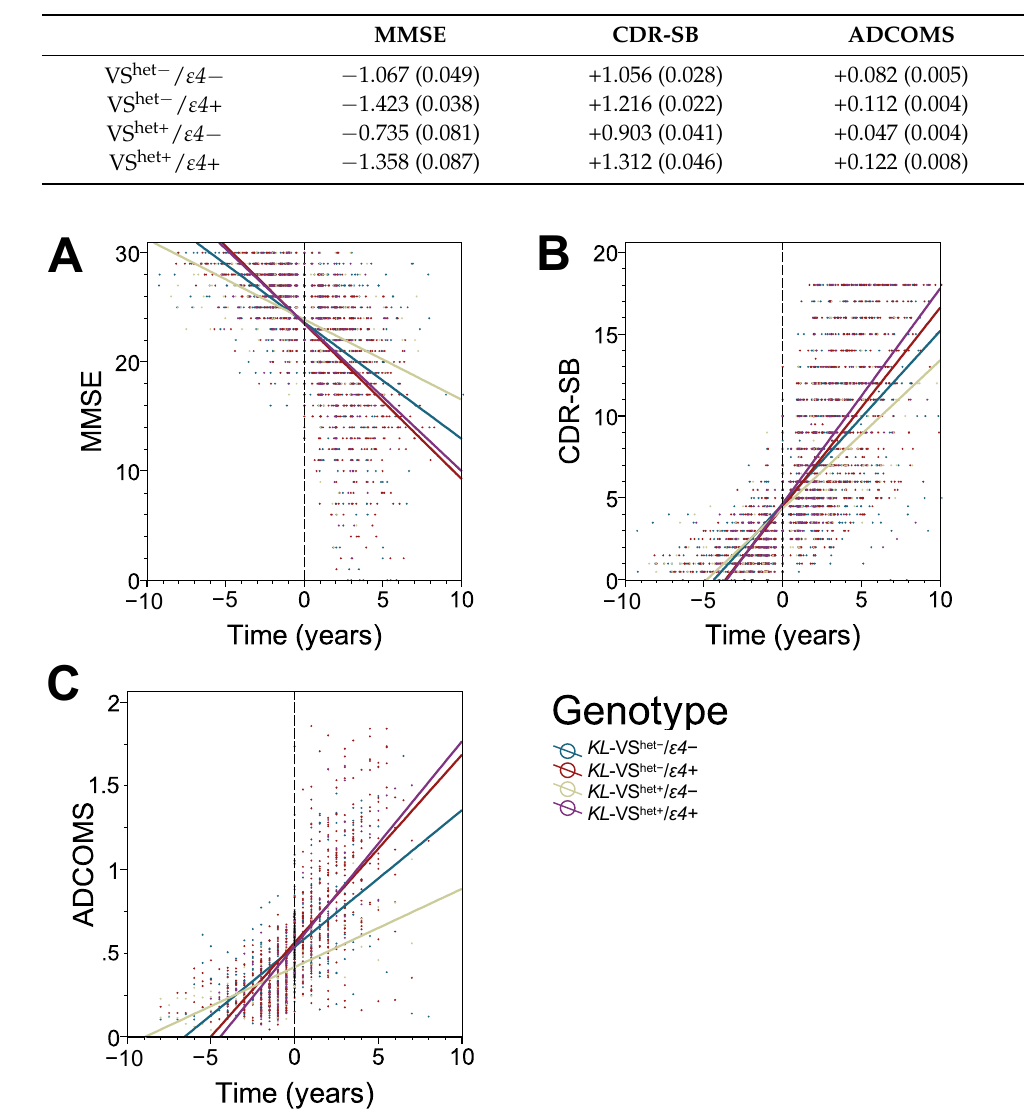
Figure 1. KL -VS het+ status significantly reduces rate of cognitive decline in AD patients who are APOE ε 4 allele non-carriers but not in those who carry the ε 4 allele. Shown are nonparallel linear regression plots with distinctive slopes reflecting the interaction between KL -VS het+ status and APOE ε 4 allele carrier status in the complete, sex-mixed cohort on Mini-Mental State Examination (MMSE) ( A ), Clinical Dementia Rating Sum of Boxes (CDR-SB) ( B ), and AD Composite Score (ADCOMS) ( C ). Solid colored lines represent lines of best fit through individual data points in a scatterplot. Negative time variable values represent the number of years before transition from MCI to AD dementia, and positive values represent the number of years after the transition to AD dementia. The 0 values represent the clinical visit a participant for the first time received a diagnosis of AD